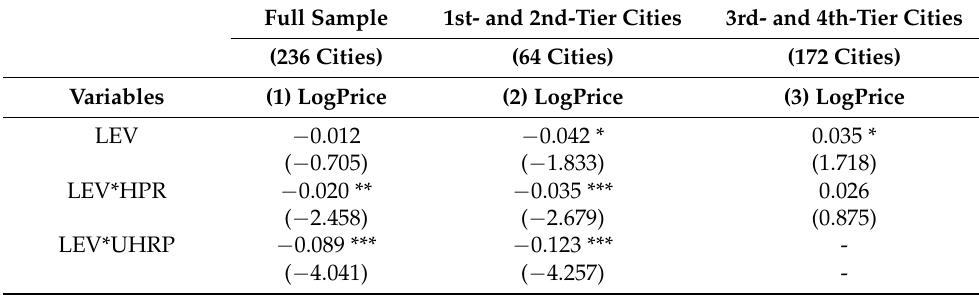
Table 4. Housing purchase restrictions and the depressing effect of urban leverage on housing